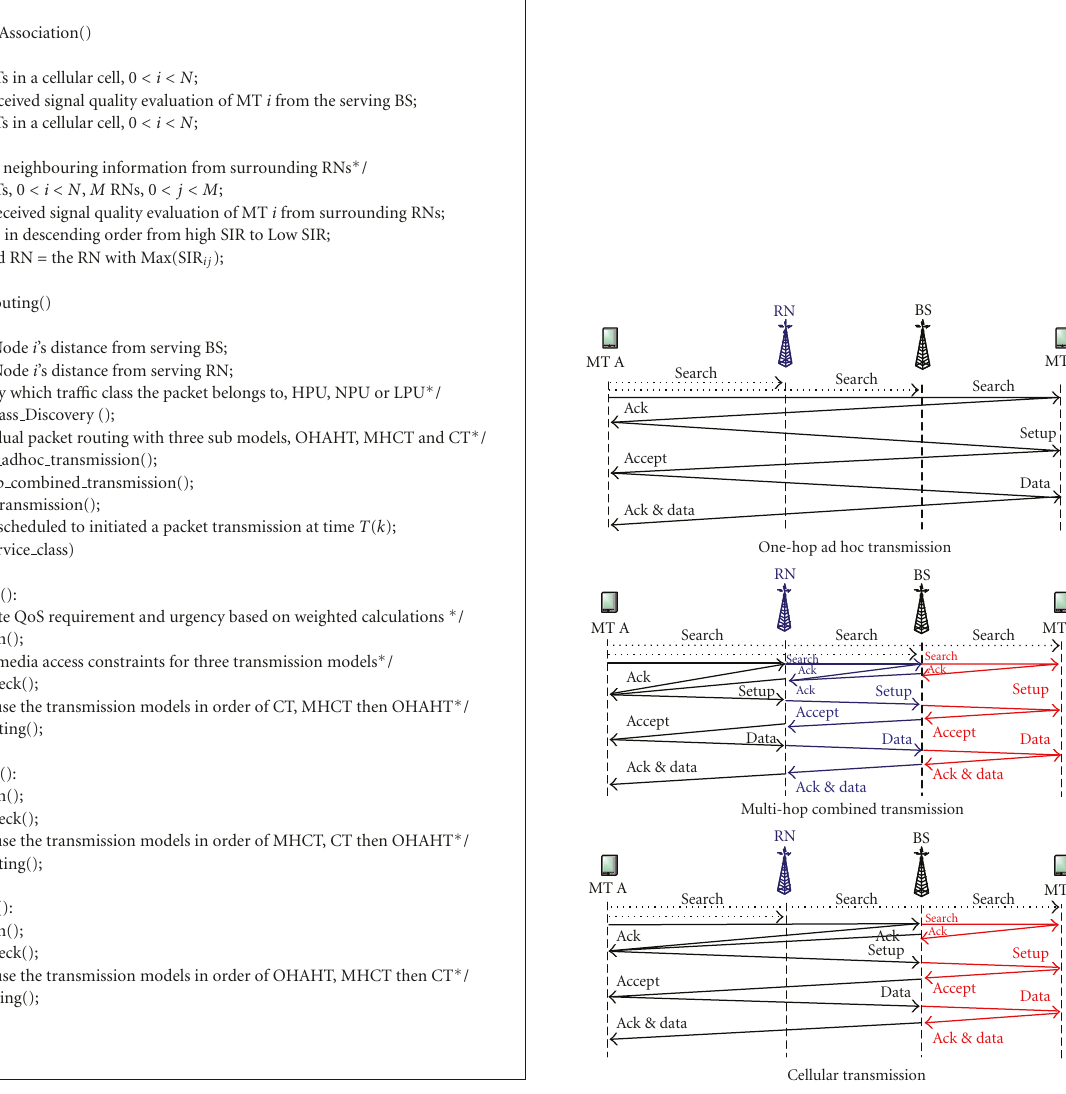
Figure 5: Computerised ADCR algorithm and simplified transmission modes